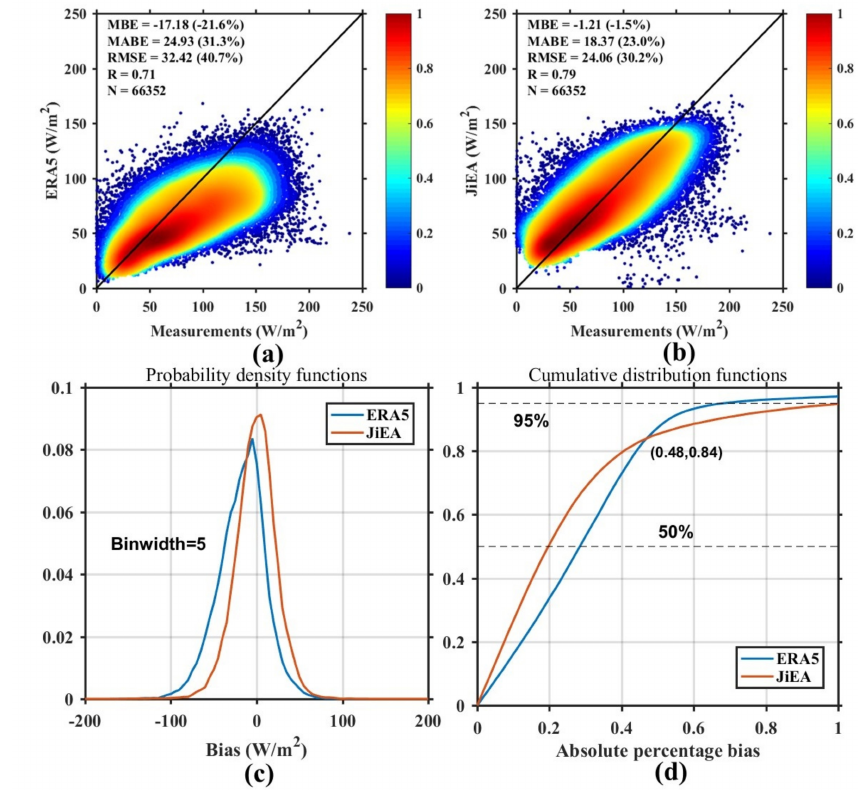
Figure 3. Evaluation results of daily mean R dif estimates. ( a – d ) Analogous to Figure 2 but at daily mean scale using measurements from WRDC and